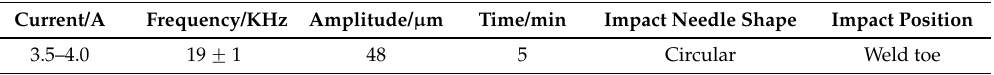
Table 2. The parameters of the ultrasonic peening treatment.